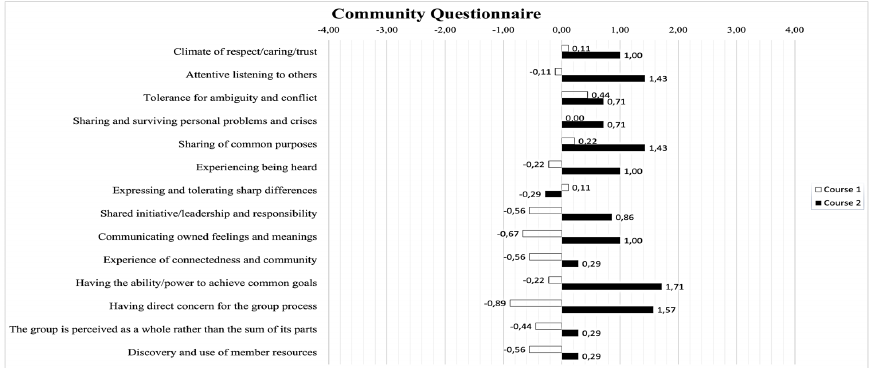
Fig. 2. Change in aspects of community in both courses, questionnaire designed by [28] and integrated in the context of computer science by [27]. The bars depict the mean value, scale from -4 (declined) to + 4 (improved), n=9 (Course 1) and n=7 (Course 2)